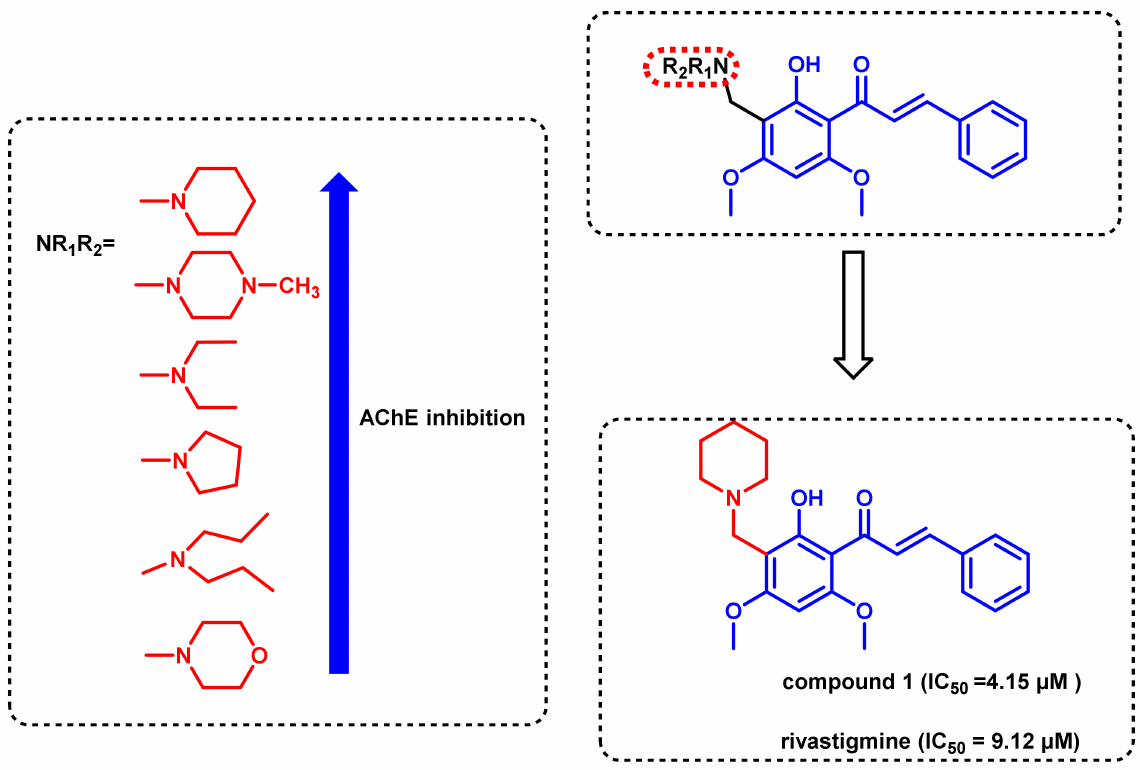
Figure 8. Chalcones inspired from Flavokawain Mannich